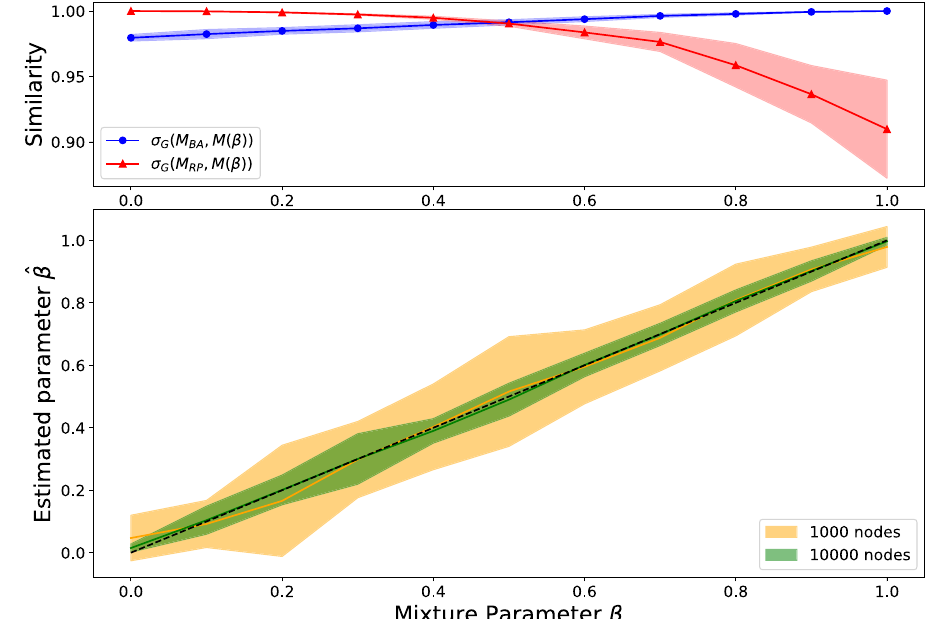
Figure 4. The upper plot shows the average model similarity values σ G ( M BA , M (β)) and σ G ( M RP , M (β)) where G is the network of 1000 nodes generated from model M (β) . The lower plot shows the performance of the ˆ β maximum likelihood estimator in recovering the true mixture parameter β of the model combining the BA and rank-preference mechanisms. In both plots, the shaded region represents a 95% confidence interval over 10 repetitions, and each synthetic network was generated by, starting from a clique of 5 nodes, adding a single node at each iteration and connecting to m = 3 existing